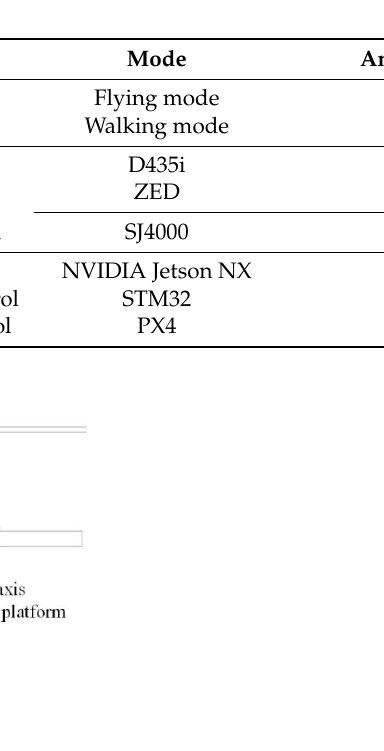
Figure 2. The installation position of cameras.